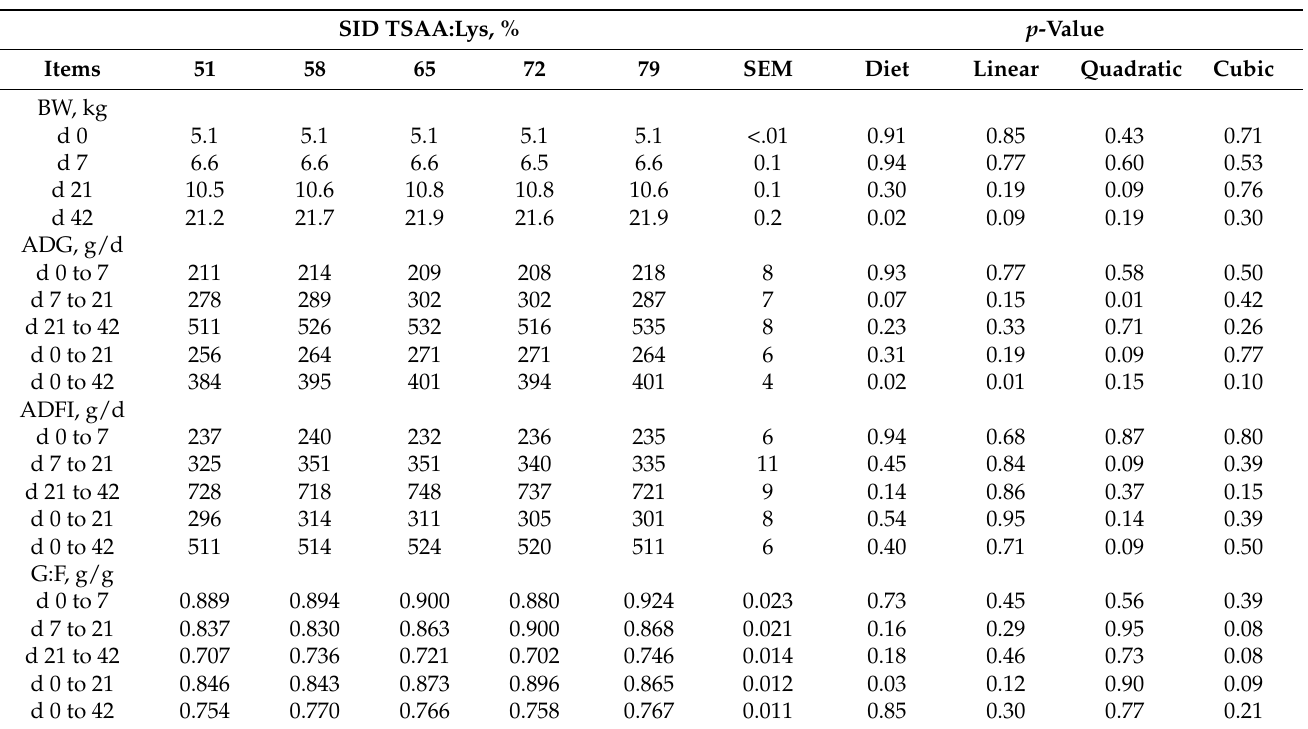
Table 4. Effect of increasing standardized ileal digestible total sulfur amino acids to lysine ratios on growth performance of nursery pigs raised without antibiotics (Experiment 2).